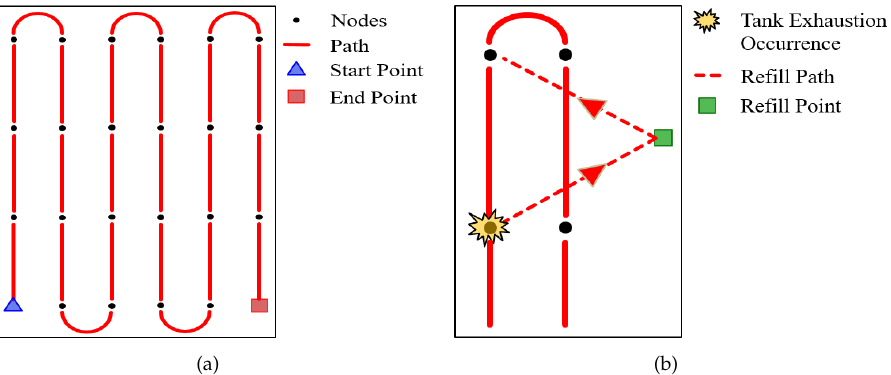
Figure 5. ( a ) Example of computing the path. The paths are computed in a straight line along the nodes in a row. ( b ) Example of computing refill planning. When the tank is exhausted, the robot moves to the closest refill point, charges the seeds, and then returns to the next node to resume the task.